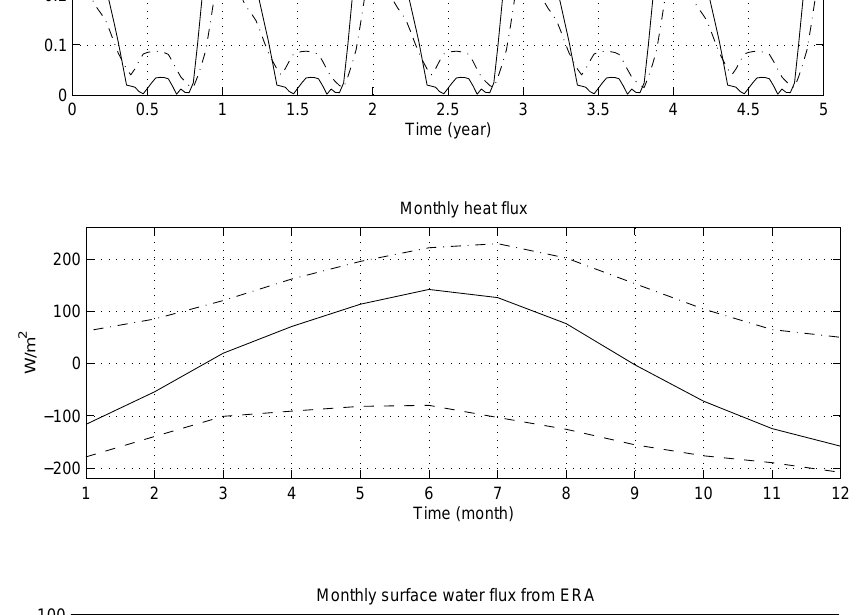
Fig. 4. The perpetual annual cycle of the east-west (solid line) and north- south (dashdot line) mean ERA wind stress components. Units are dyne/cm 2 .